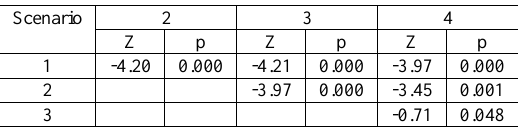
Table 6. Wilcoxon signed-rank test results (dominant hand)